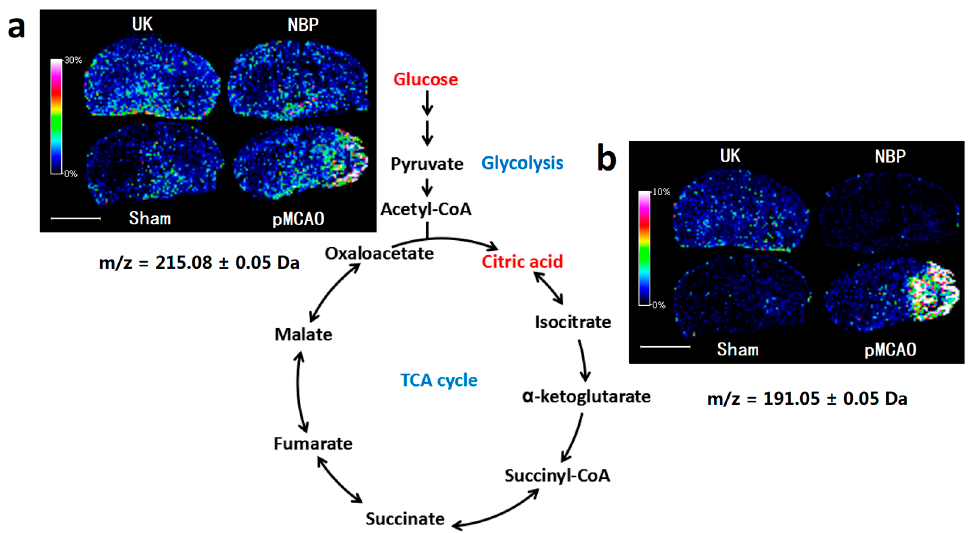
Figure 3. Dl-3-n-butylphthalide alleviated the abnormal accumulation of glucose and citric acid in a rat model of pMCAO. Matrix-assisted laser desorption ionization time of flight mass spectrometry (MALDI–TOF–MS) imaging of ( a ) glucose and ( b ) citric acid. The spatial resolution was set to 200 µm. m/z: mass-to-charge ratio. Scale bar = 5 mm. n = 3. Sham: sham surgery group; pMCAO: pMCAO group; NBP: dl-3-n-butylphthalide-treated group; UK: urinary kallidinogenase-treated group.